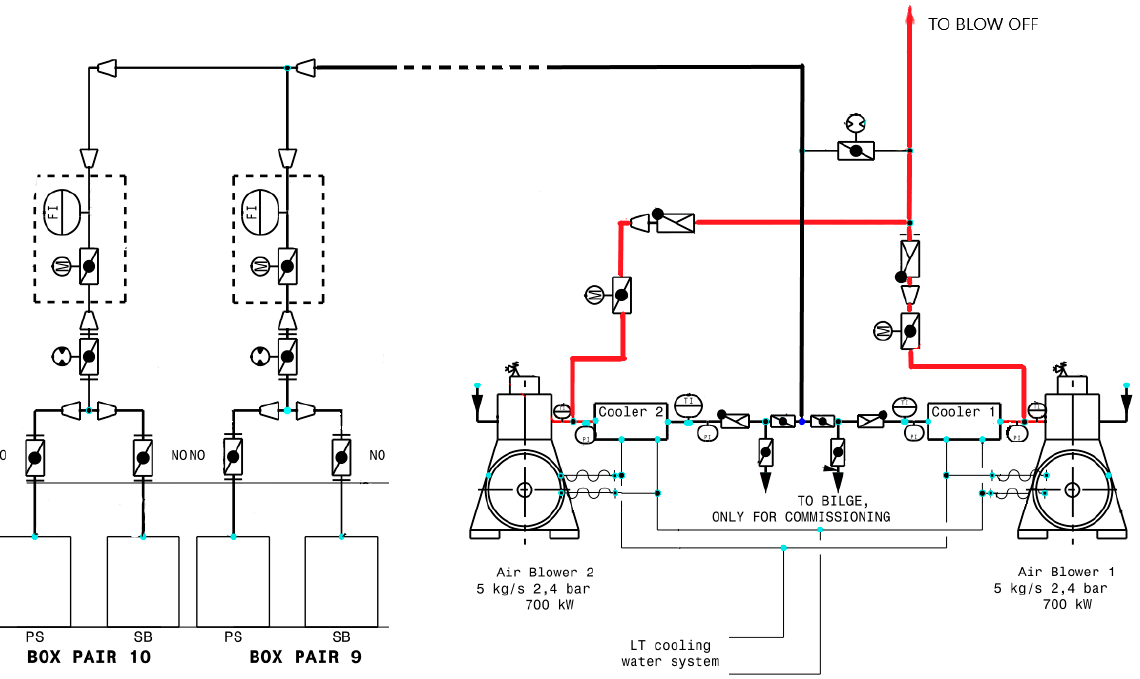
Figure 5. Compressed air supply system (ALS) of the underwater part of the hull on a large cruise liner. The blowers forced compressed air to 20 distribution boxes (10 pairs) which are a structural element of the ship’s hull. Two distribution boxes: one box on the port side and one on the port side are symmetrically connected to one supply subline. The boxes are equipped with corrosion protection (zinc anodes). The compressors run at a constant speed and are controlled by a control system, which can reduce the capacity of one com- pressor to about 45% of nominal value. This is executed by regulating the air supply with steering wheel with variable angle blades. In this way the energy consumption of the blowers driving motors can be reduced. The ALS method may be applied at the design stage and built on a new vessel as well as installed on the vessel after a certain period of operation. The introduction of ALS on operated ship is a complicated process and requires comprehensive analyses, calculations, measurements and most often computer simulations [24]. There are several companies specializing in the design and installation of ALS on the vessels and each company calls this system otherwise i.e.: Mitsubishi Co. – Mitsubishi Air Lubrication System (MALS), R&D Engineering – Winged Air Induction Pipe System (WAIP), Samsung Heavy Indus- tries – SAVER System (SAVER Air), Silverstream-Silverstream System, Foreship-Foreship Air Lubrication System (Foreship ALS) and others [5]. The first installation of the ALS called Silverstream System (Addlestone, UK) was applied on a chemical tanker MT Ama- lienborg with a carrying capacity of 40,000 DWT. This vessel was equipped for propulsion with a low-speed B&W 6S50MC main engine with power of 13,452 BHP [25]. After in- stalling this system on the ship many operation parameters when ALS was ON and OFF were recorded, among others: propulsion system operation parameters and ship speed (on water and GPS), as well as power consumption by blowers, main engine speed, shaft power (torque), fuel consumption by main engines. And additionally, weather conditions (hydrometeorological conditions). Figure 6 shows the impact of ALS (Silverstream system) operation installed on MT Amalienborg on the changes of the propulsion power (shaft power) and ship speed. The